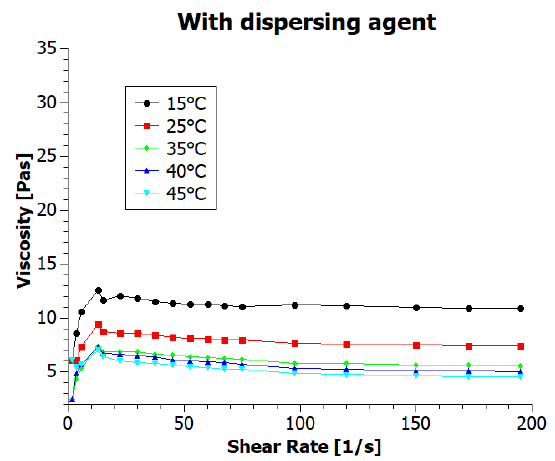
Figure 4. Viscosity curves of graphene ink with dispersing agent at various temperatures.